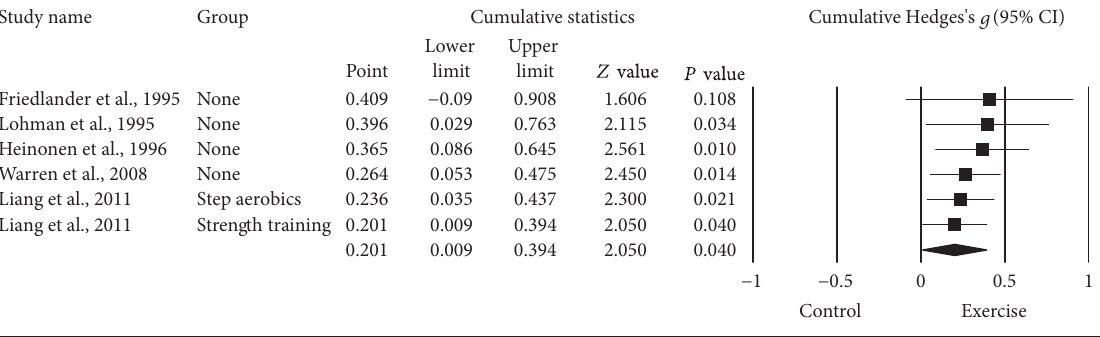
Exercise ) while the le and right extremes of the ) while the le and right extremes of the diamond 𝑔𝑔 𝑔𝑔